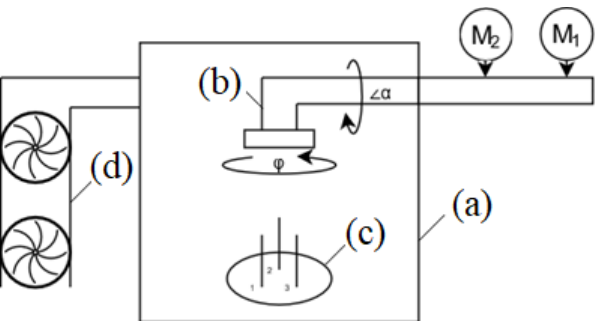
Figure 3. Scheme of GLAD machine, details are given in Table 1. Table 1. Description of the elements listed.